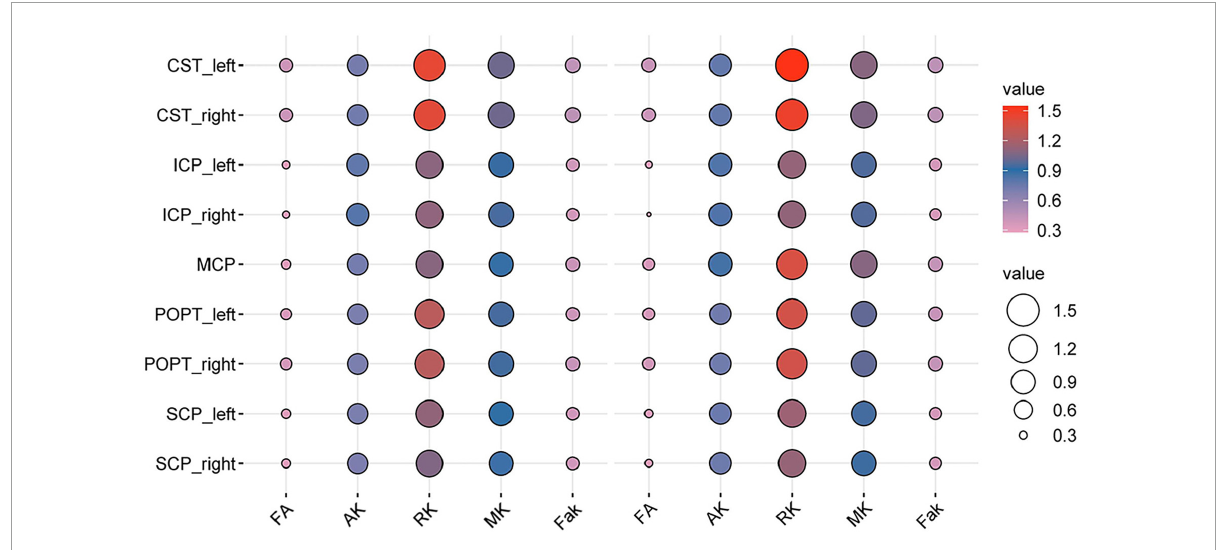
FIGURE4 Bubble plot of the DKI-derived values of the specific white matter (WM) tracts between the patients with BSG and controls (the left five columns were the DKI-derived values of the patients’ group, the right five columns were the DKI-derived values of healthy